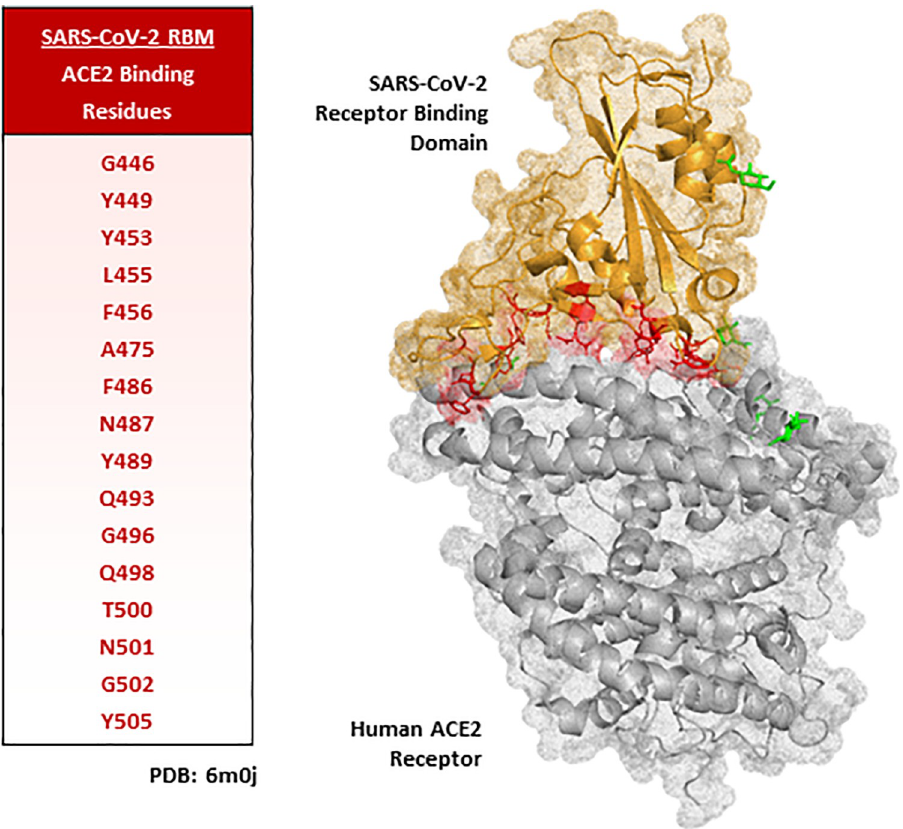
Fig 1. SARS-CoV-2 receptor binding motif–ACE2 protein-protein interaction binding interface. Amino acids in red highlight SARS-CoV-2 receptor binding motif (RBM) contact residues with ACE2.–adapted from (Lan, et al. 2020) [7]. ACE2 receptor–Grey. SARS-CoV-2 RBD–Orange. Green structures represent glycoproteins. Structure generated using PyMol software.